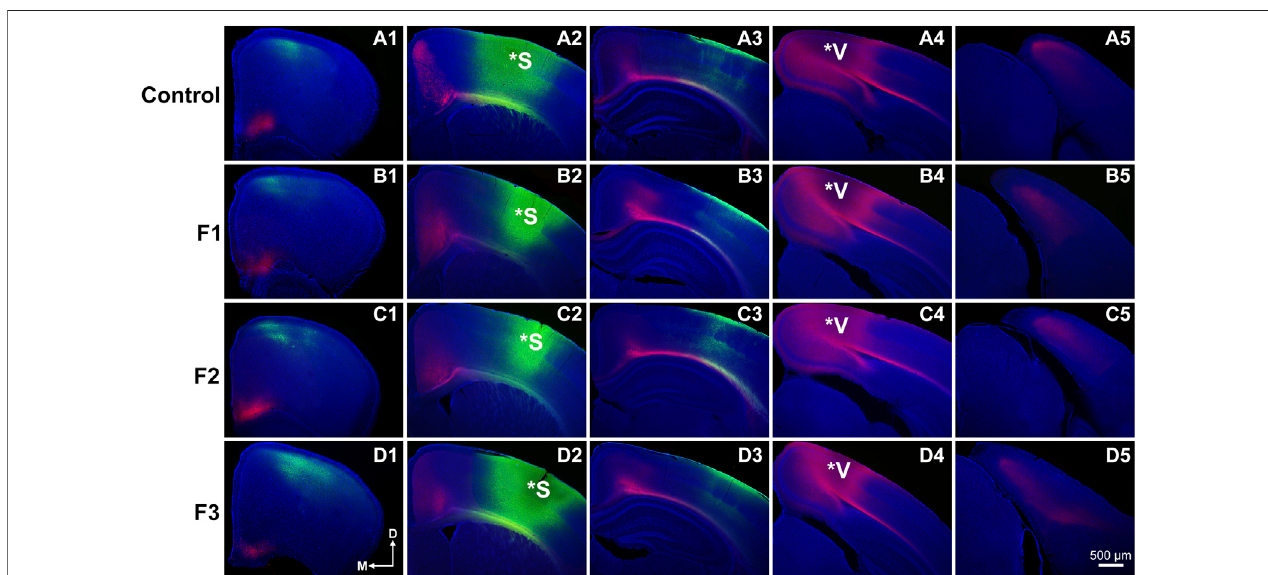
FIGURE 4 | Analysis of primary somatosensory (S1) and primary visual (V1) cortex INC patterns at P20. Rostral-to-caudal series of hemisected coronal sections in individual representative Control (female, A1-4 ) and F1 (male, B1-4 ), F2 (female, C1-4 ) and F3 (male, D1-4 ) P20 mice brains following DiA (green) placement in S1 (*S, A2-D2 ) and DiI (red) placement in V1 (*V, A4-D4 ). No signi fi cant phenotypic differences in S1 or V1 projection zones were found between experimental and control brains. All 100 μ m sections counterstained with DAPI (blue). Images oriented dorsal (D) up and medial (M) left. Scale bar, 500 μ m.